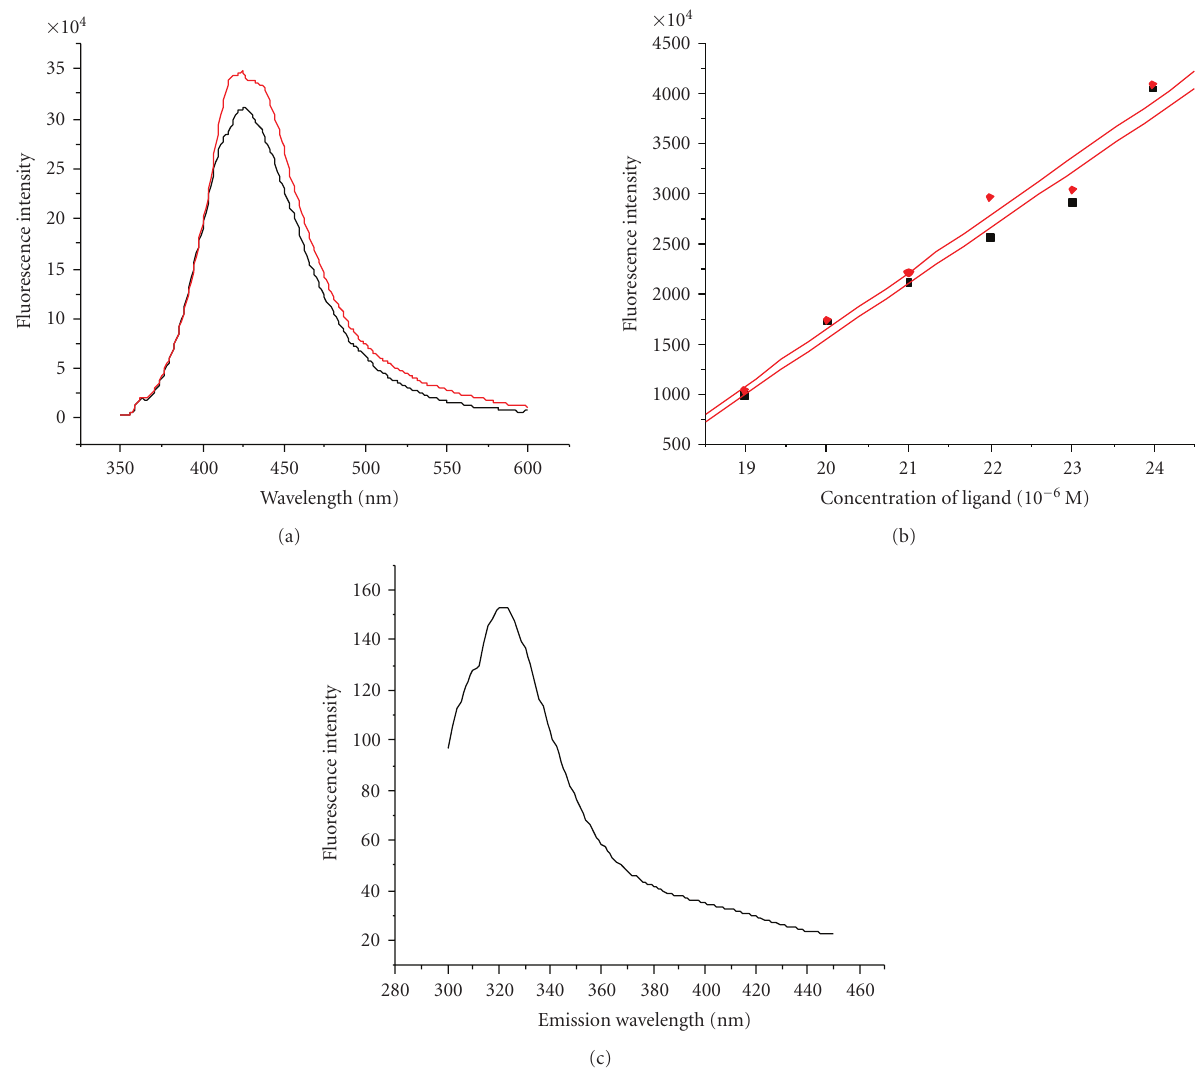
Figure 6: (a) The fluorescence intensity of Re(CO) 3 (L) (20 μ M) (black line) and Re(CO) 3 (L) (20 μ M) incubated with A β (1 ∼ 40) aggregates (red line) at the emission wavelength of 425 nm. (b) Equation (1): the nether line and Equation (2): the upper line. (c) The fluorescence intensity of EHIDA (0.4mM) and emission wavelength (excitation wavelength is